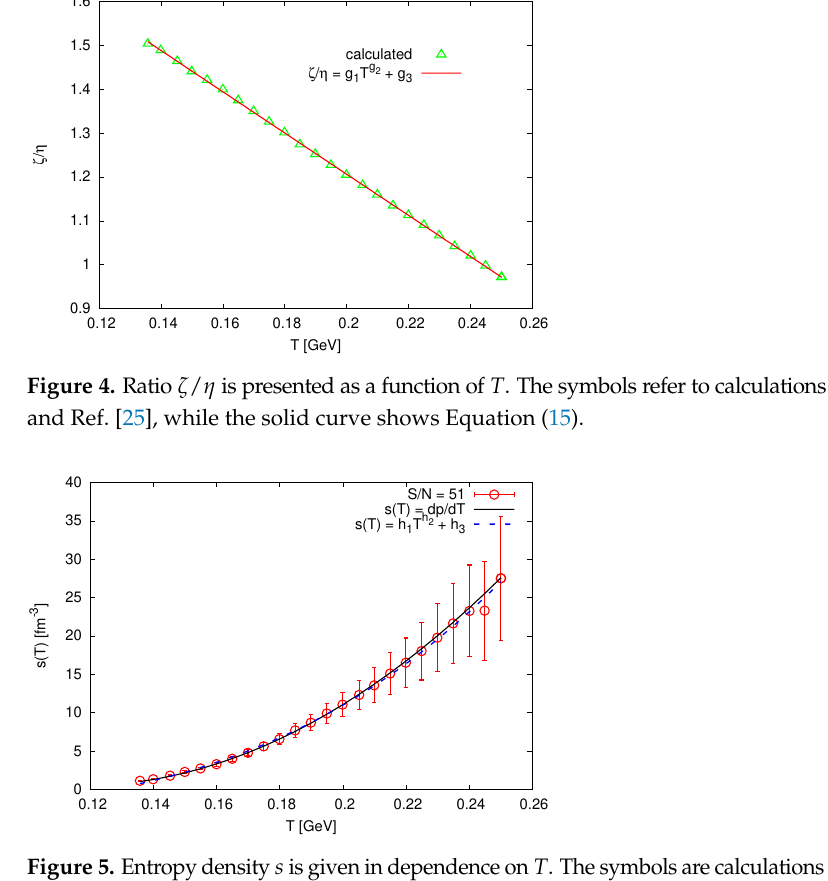
Figure 5. Entropy density s is given in dependence on T . The symbols are calculations from Equation (16). The solid curve refers to Equation